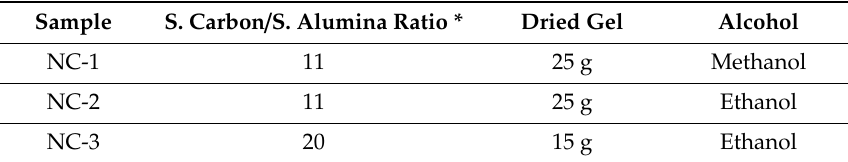
Table 1. The used materials for preparing